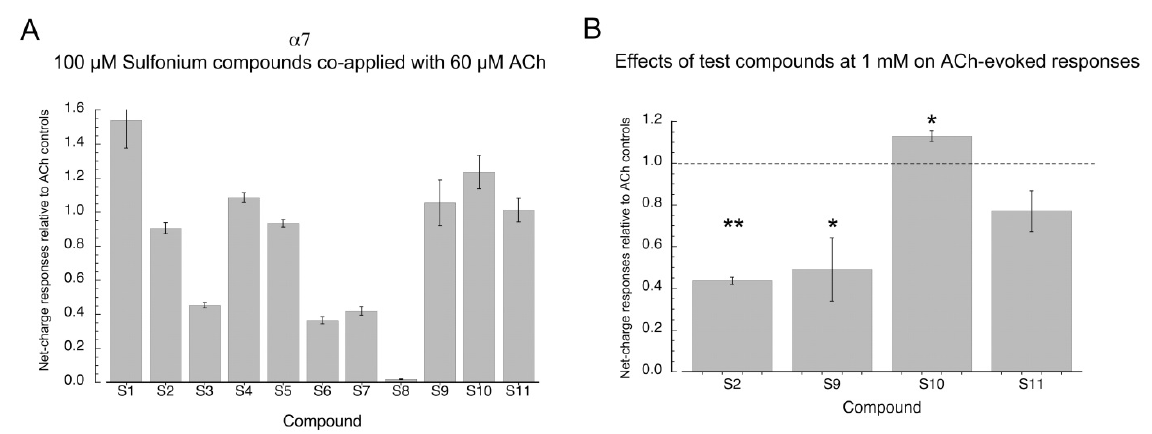
Figure 4. Effects sulfonium compounds on α 7 ACh-evoked net-charge responses. ( A ) Effects of the sulfonium compounds at 100 µM co-applied with 60 µM relative to responses to 60 µM ACh applied alone. Data are the averages (±SEM) from seven or eight cells under each condition. See Table S2 for ANOVA. ( B ) Effects of select sulfonium compounds at 1 mM co-applied with 60 µM relative to responses to 60 µM ACh applied alone. Data are the averages (±SEM) from seven or eight cells under each condition. Statistical significance was determined by pairwise t -test with p values corrected for multiple comparisons; * p < 0.05, ** p < 0.001.